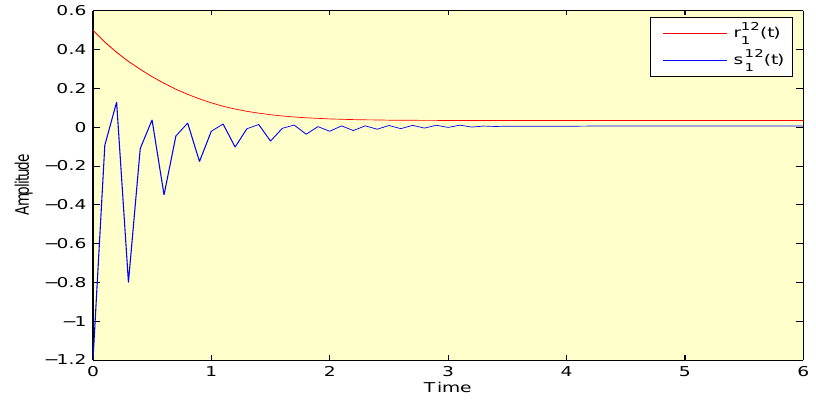
( t ) , (cid:115) 12 ( t ) of NN models (1) and (3). 1 1